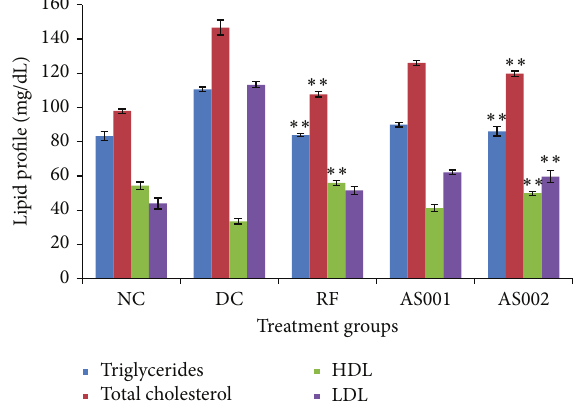
Figure 4: Effect of Pupalia lappacea extract on lipid profile of STZ induced diabetes in rats. Values are expressed as mean ± SEM (number of animals, 𝑛 = 6 ); NC = normoglycemic control, DC = diabetic control, and RF = reference group (glibenclamide, 5.0 mg/kg), significantly different at ∗∗ 𝑝 < 0.05 , ∗∗∗ 𝑝 < 0.001 when compared with diabetic control